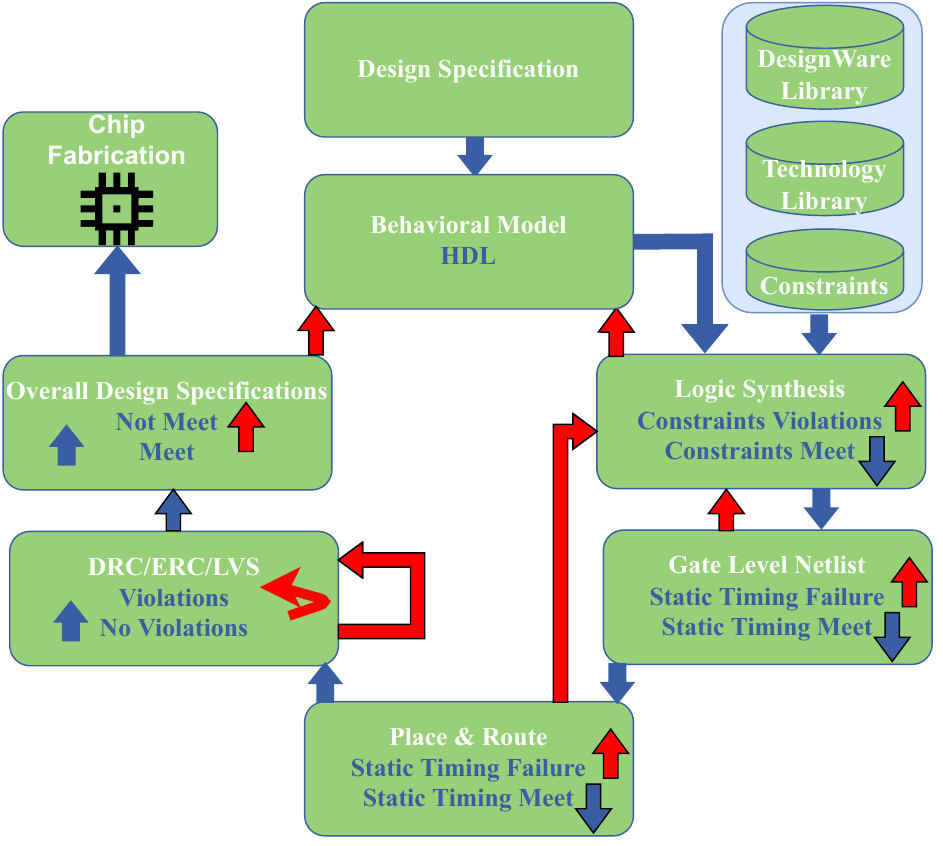
Figure 1. A vicious cycle in circuit design often begins with a hardware description of a new design and end-up after sending the tape-out to the fabrication lab by addressing several stressful iterative processes to meet the complex design rules, high-performance, and low area